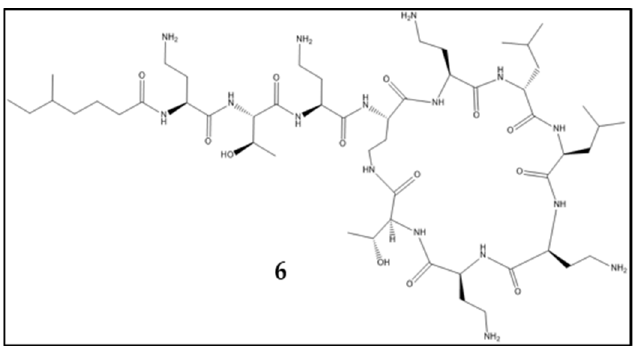
Figure 2. Structure of colistin ( 6